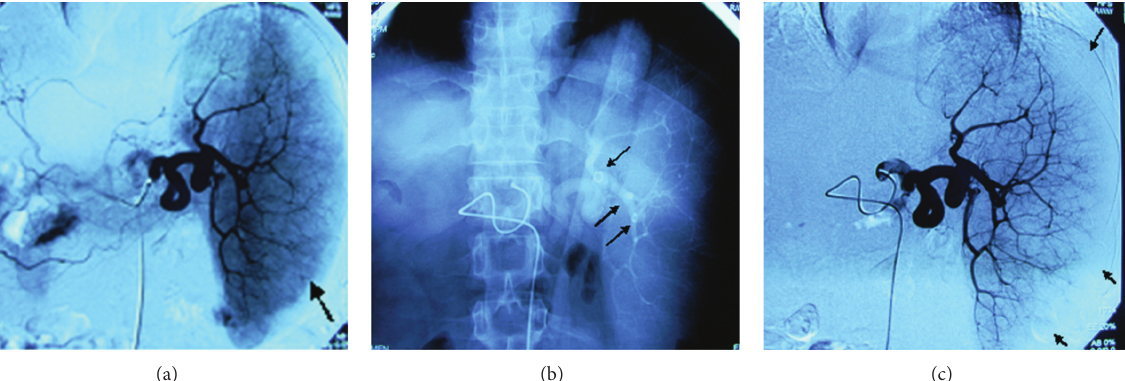
Figure 2: Embolization of the upper and lower polar arteries in combination with achieving peripheral infarction. (a) Arteriogram shows splenomegaly before PSE and abundant peripheral small arteries (arrow). (b) The upper and lower polar arteries have been embolized with coils (arrows). (c) Compared with (a), the peripheral area has scanty arterial branches